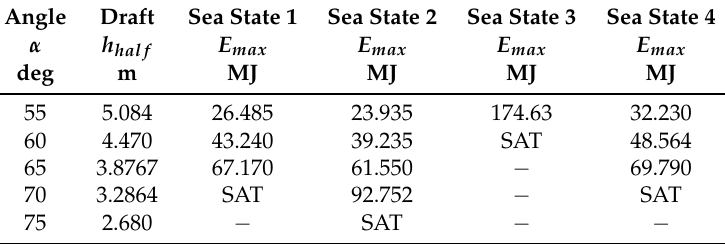
Table 4. HG buoy Bretschneider spectrum sea state